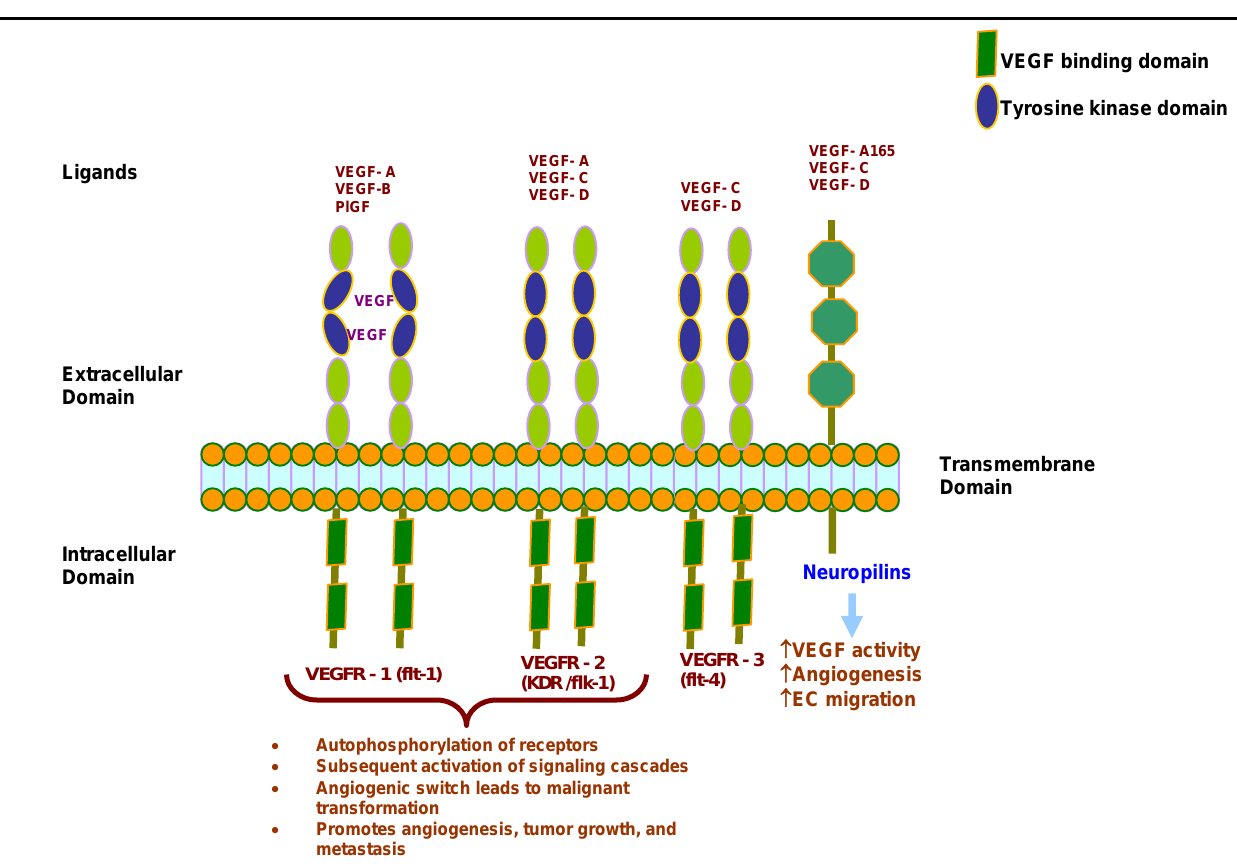
Figure 2. VEGF signaling in pancreatic cancer. Binding of ligands with VEGFRs stimulates malignant transformation of the pancreas. EC = endothelial